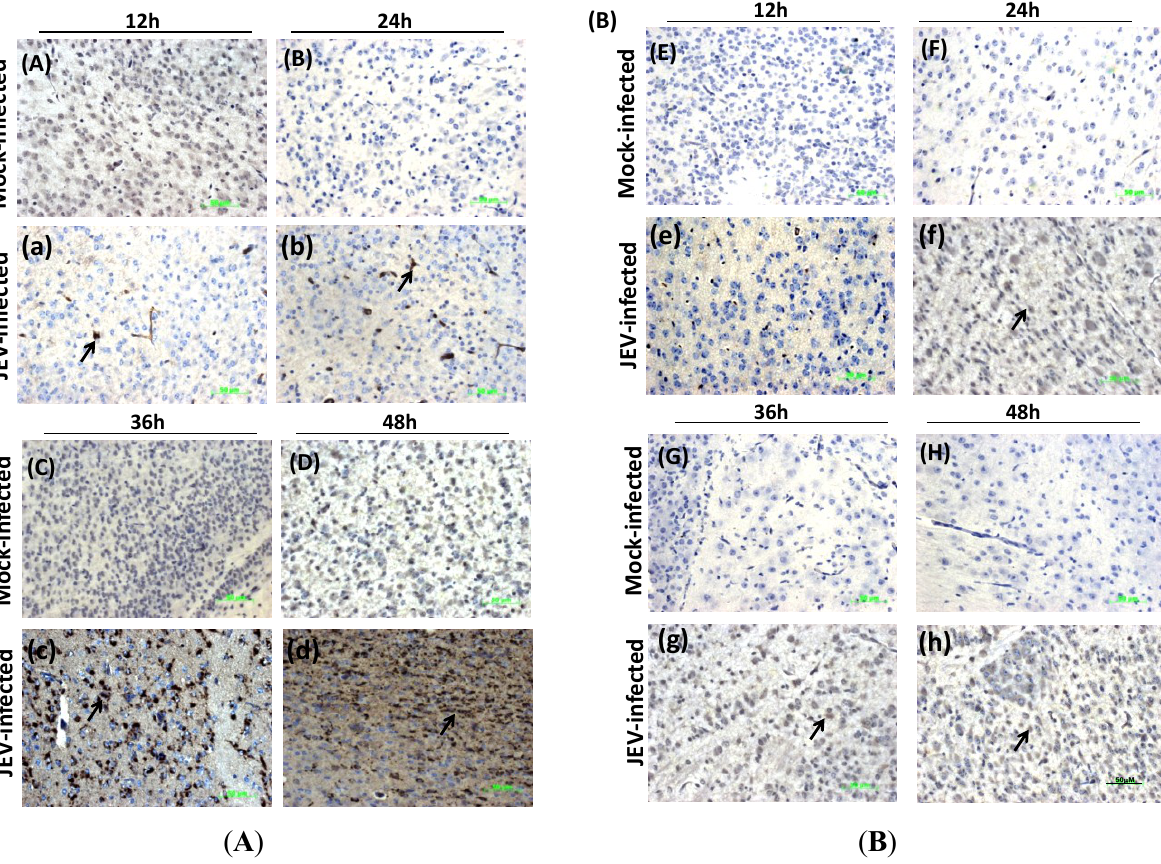
Figure 5. Immunohistochemistry analysis for JEV envelope (E) protein ( A ) or SOCS3 ( B ) expression in mock-infected or infected mice brains at different time points